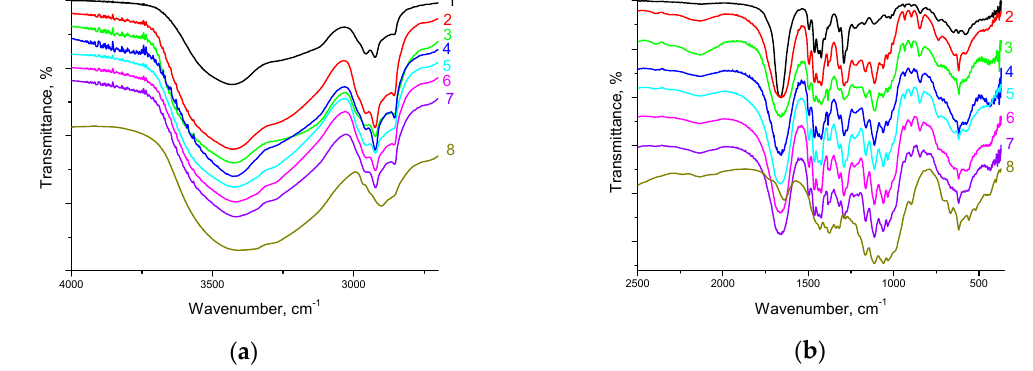
Figure 2. FTIR spectra of the PVP/CNC composite films: 1 - neat PVP; 2 - PVP/CNC-4.6; 3 - PVP/CNC-10.9; 4 - PVP/CNC-16.3; 5 - PVP/CNC-19.6; 6 - PVP/CNC-28.9; 7 - PVP/CNC-37.9; 8 - neat CNC: ( a ) in the range of wavenumbers of 4000–2500 cm − 1 ; ( b ) in the range of wavenumbers of 2500–500 cm − 1 . PVP, polyvinylpyrrolidone; CNC, cellulose nanocrystals.